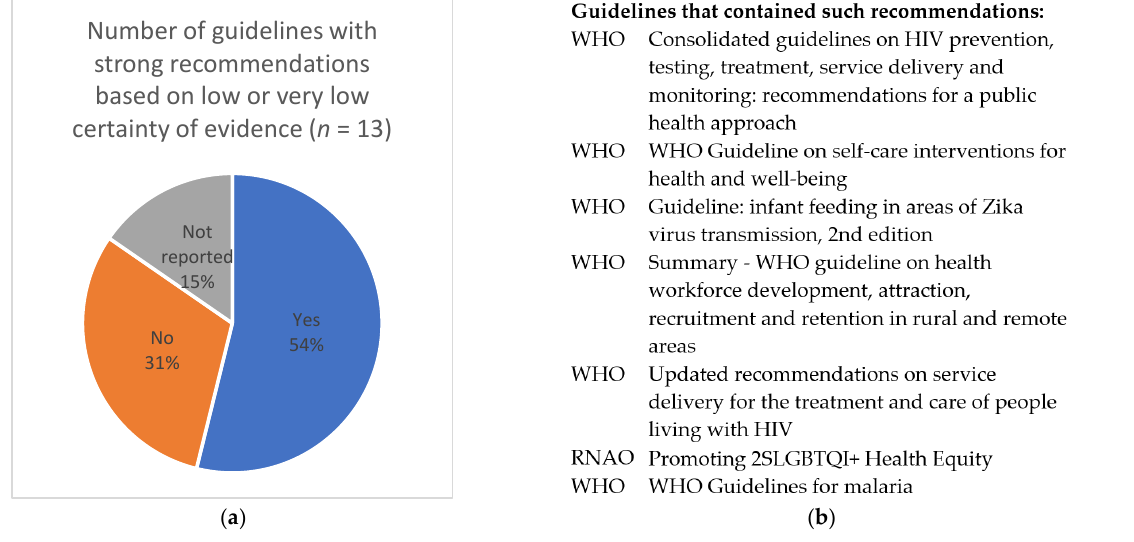
Figure 7. ( a ) Developing strong recommendations based on low or very low certainty of evidence; ( b ) a list of guidelines with strong recommendations based on low or very low certainty of